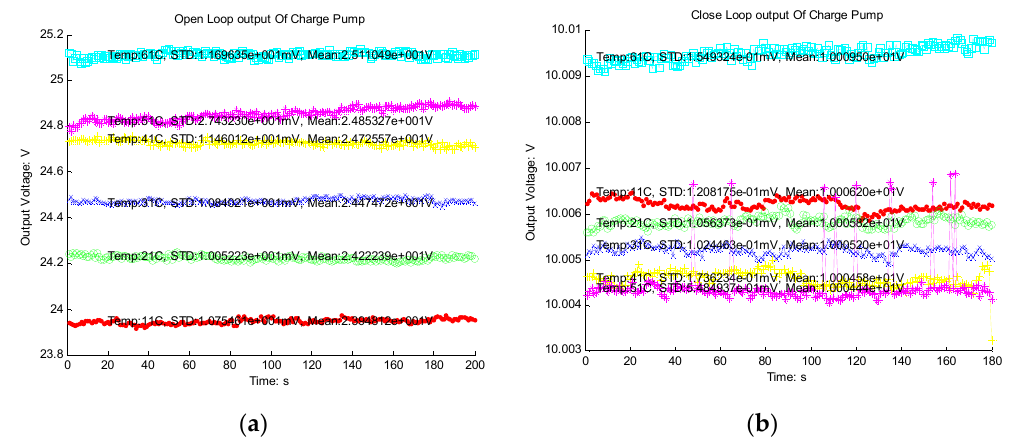
Figure 7. Charge pump: ( a ) Output of cascade charge pump; ( b ) Output of charge pump system with control module.